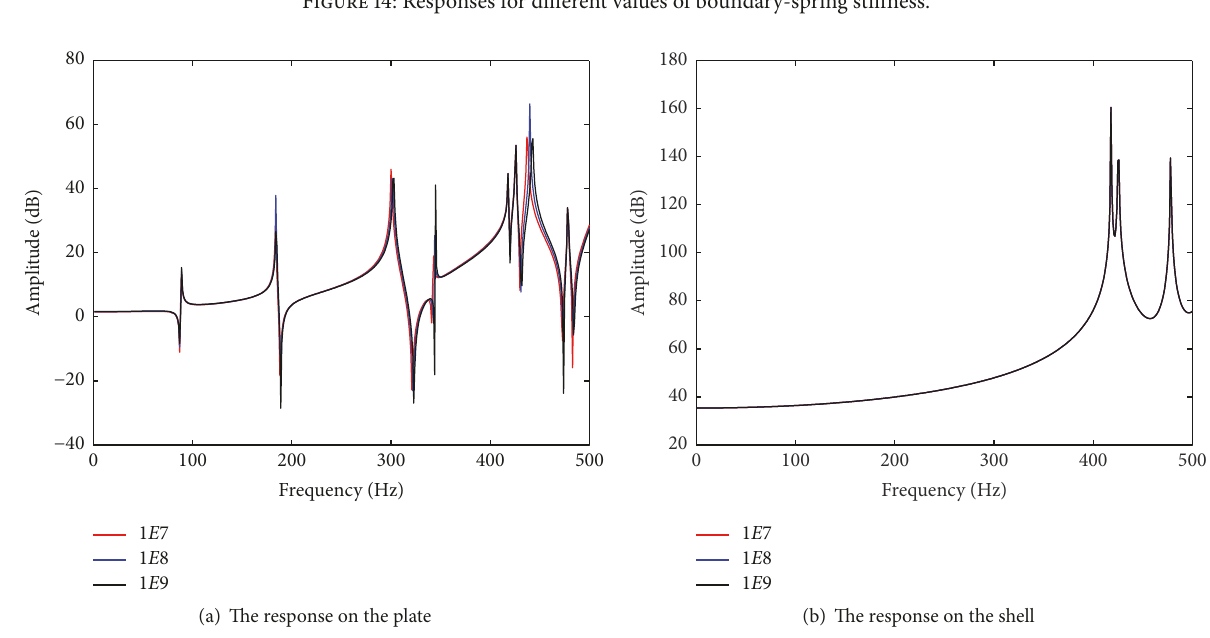
Figure 15: Responses for different values of coupling-spring